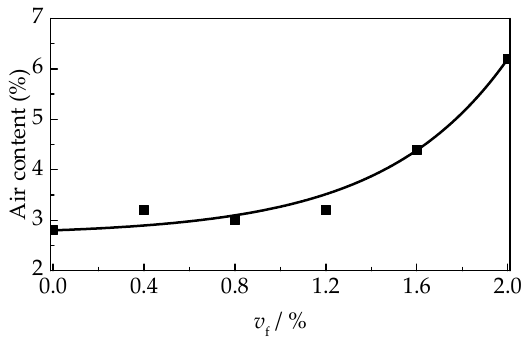
Figure 8. Variation of the air content with v f.